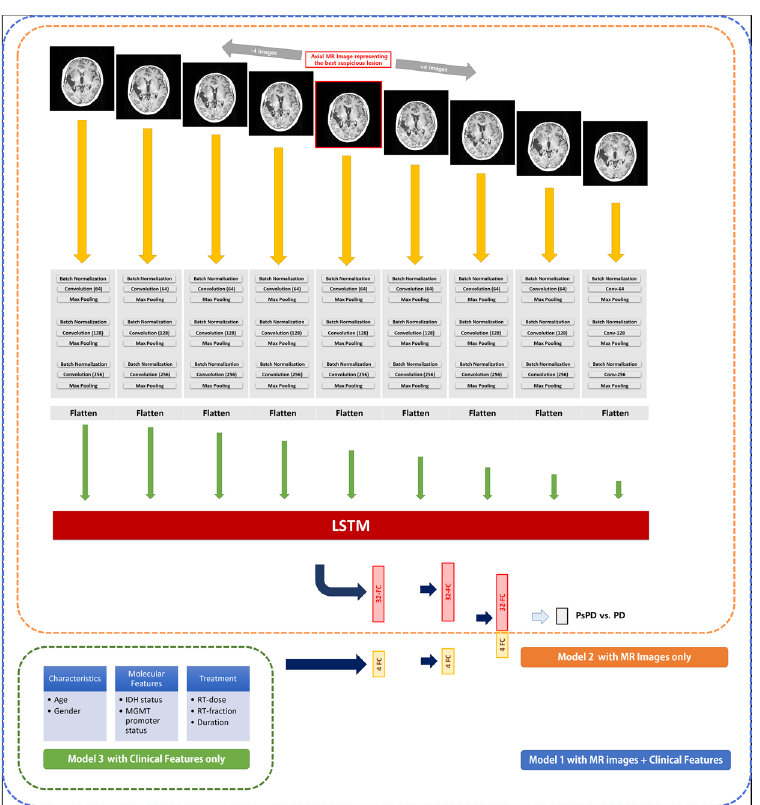
Figure 1. Schematic representation of the structures of the three models. In Model 1 (blue), selected 9 axial MR images were passed through CNN-LSTM, and clinical features were passed into two FCs with four nodes. In Model 2 (orange), only selected 9 axial MR images passed were passed through CNN-LSTM. In Model 3 (green), random forest model using only clinical factors were used. The output is a probability corresponding to PsPD or PD. The number in parentheses in ‘Convolution’ layer means the number of filters made by 2 × 2 pixels kernel. Abbreviations: LSTM, long short-term memory; ML, machine learning; FC, fully-connected layer; PD, progressive disease; PsPD, pseudoprogression; MGMT, O6-methylguanine-DNA-methyltransferase; IDH, isocitrate